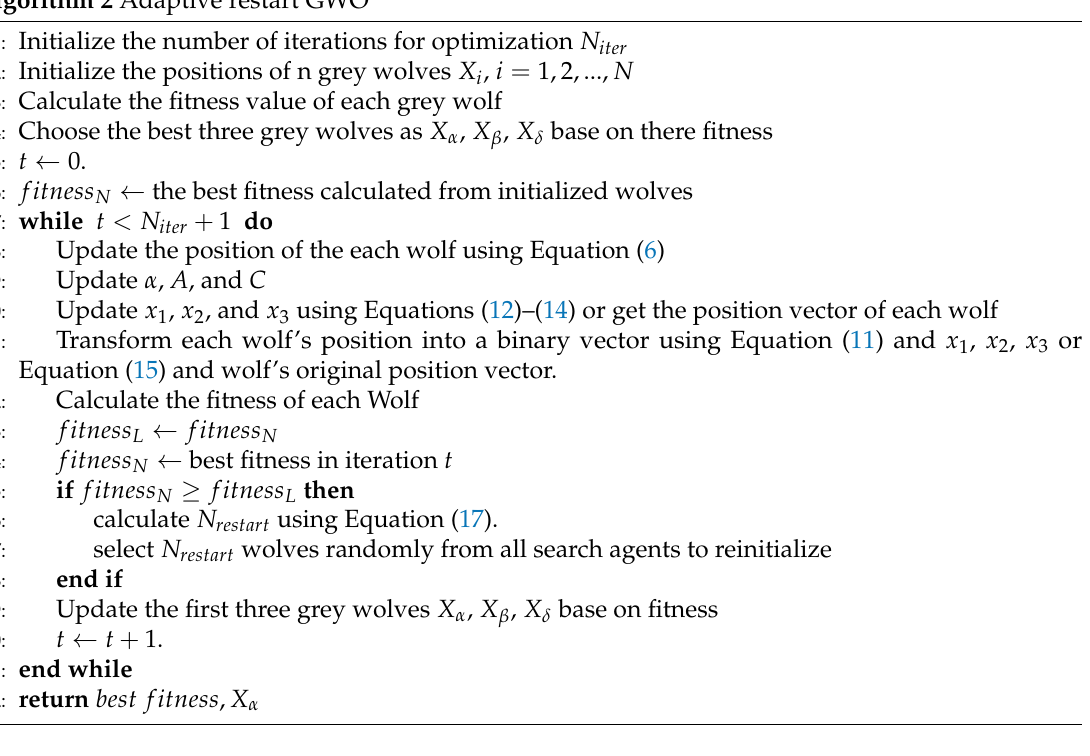
Algorithm 2 Adaptive restart